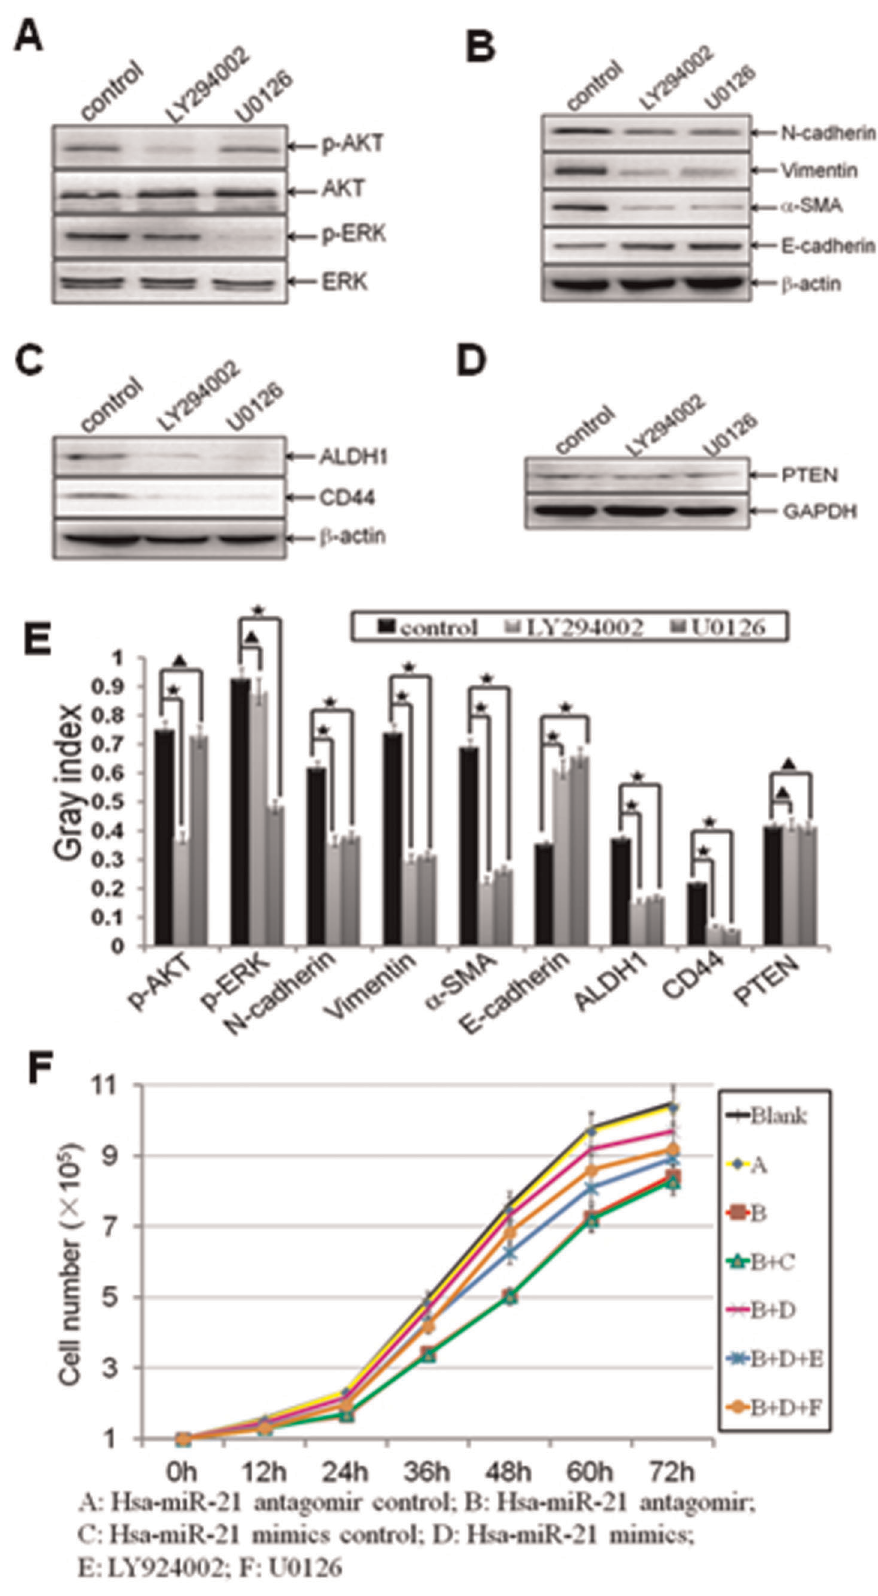
Figure 6. MiR-21 regulated EMT and CSC phenotype through mediating AKT and ERK1/2 activation. Established MDA-MB-231/anti-miR- 21 cells were transfected with hsa-miR-21 mimics at a concentration of 40 nmol for 72 h. Then the cells were trypsinized, and treated with LY294002 (20 m mol/l) or U0126 (10 m mol/l) for 24 h. (A-E) The relative protein levels of p-AKT and AKT (A), p-ERK and ERK (A), EMT markers (B), CSC surface